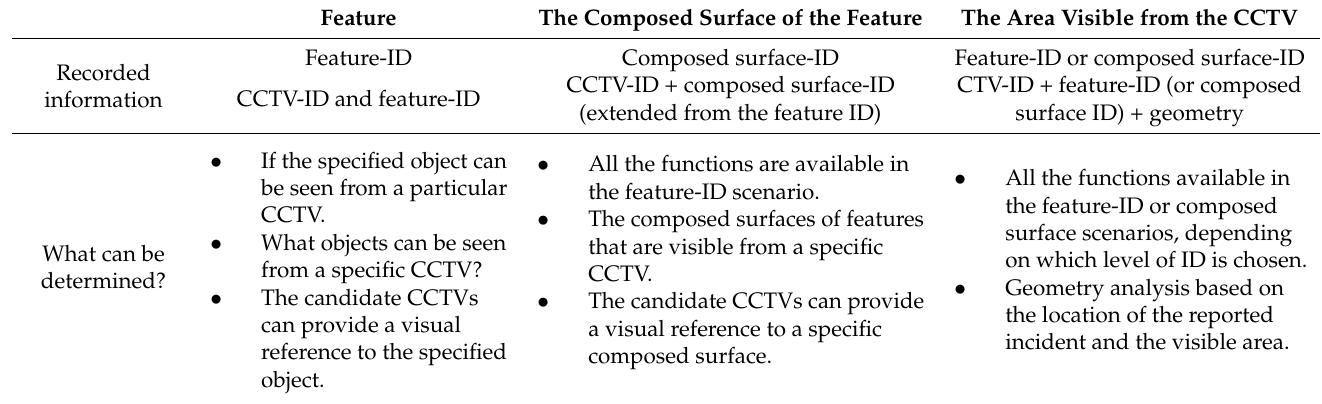
Table 1. The recording method between the CCTV camera 3D FOV and the